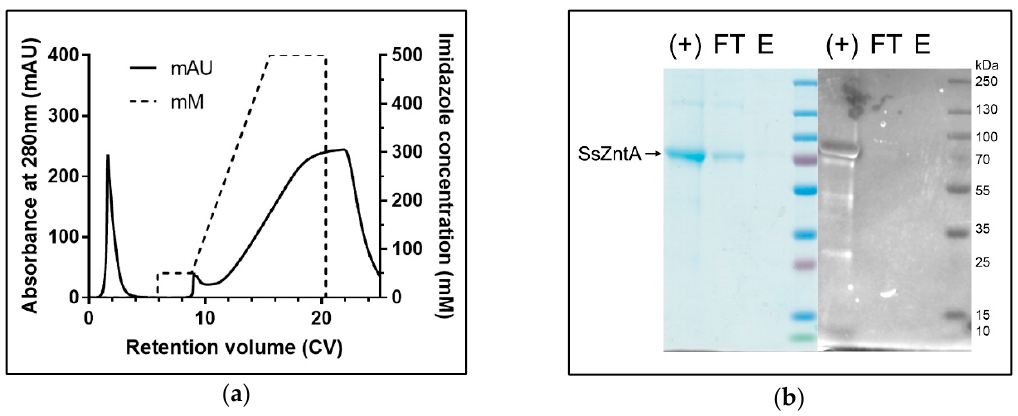
Figure 8. SsZntA-Nb complex analysis using affinity chromatography: SsZntA only. ( a ) Chromatogram of HisTag-free SsZntA loaded on an Ni 2+ -immobilized column. Without Nb, the ATPase elutes in the flow through (control). ( b ) Coomassie (left) and InVision ® (right) stained SDS-PAGE of HisTagged SsZntA as positive control for the staining (+), flow through (FT), and eluted fraction (E) of HisTag free SsZntA loaded on the Ni 2+ -immobilized resin as negative control.